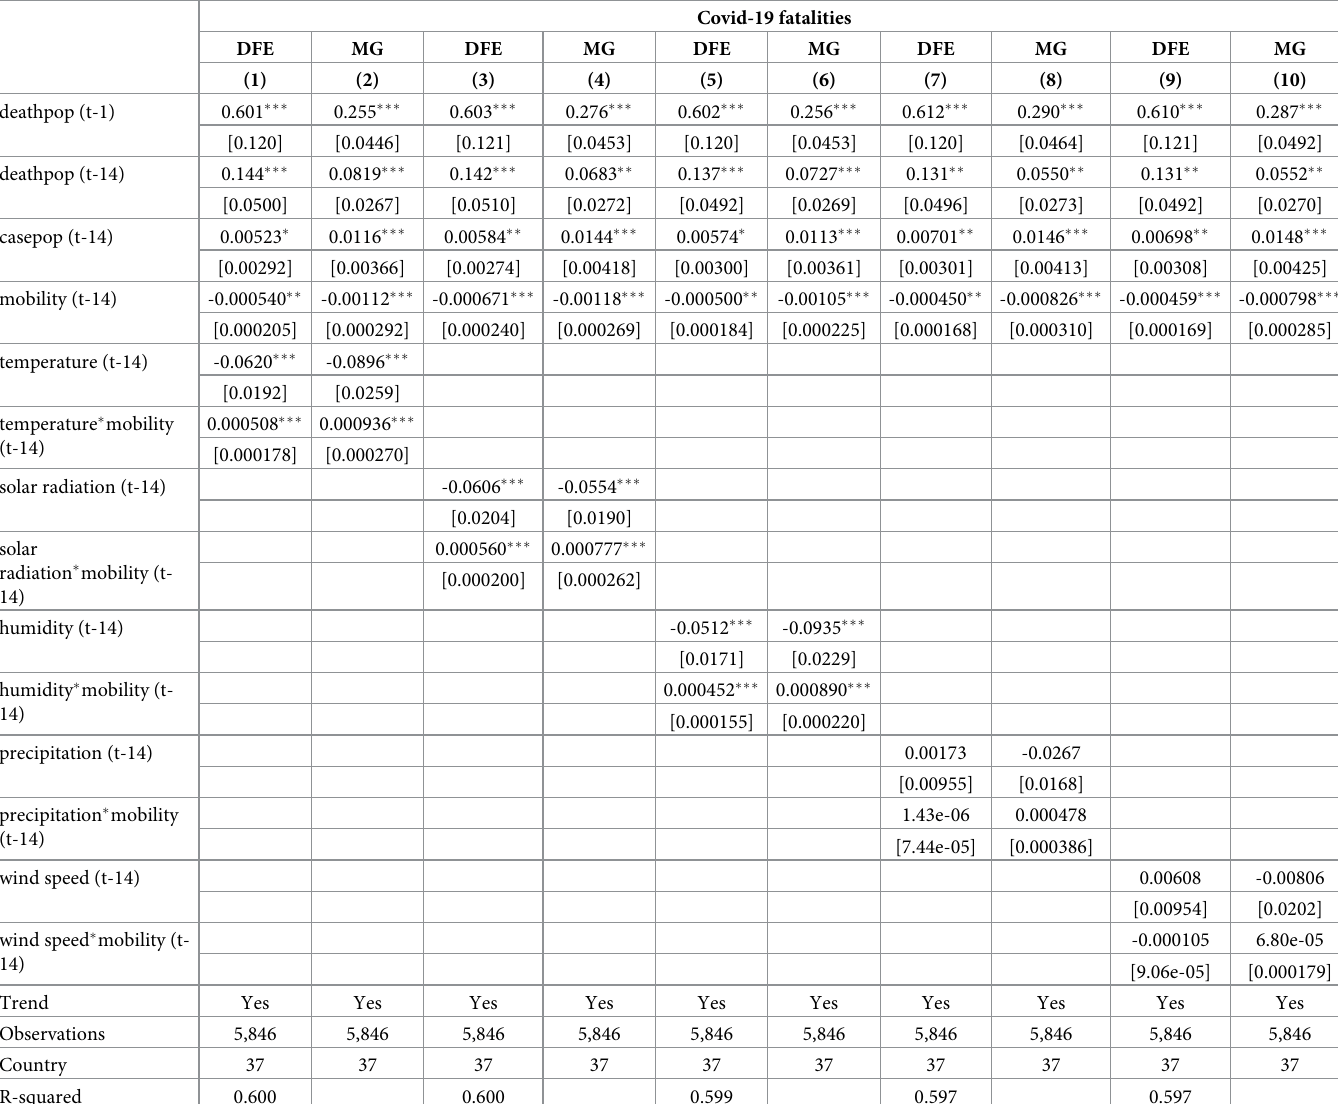
Table 7. Indirect effects of climate variables on Covid-19 fatalities through human